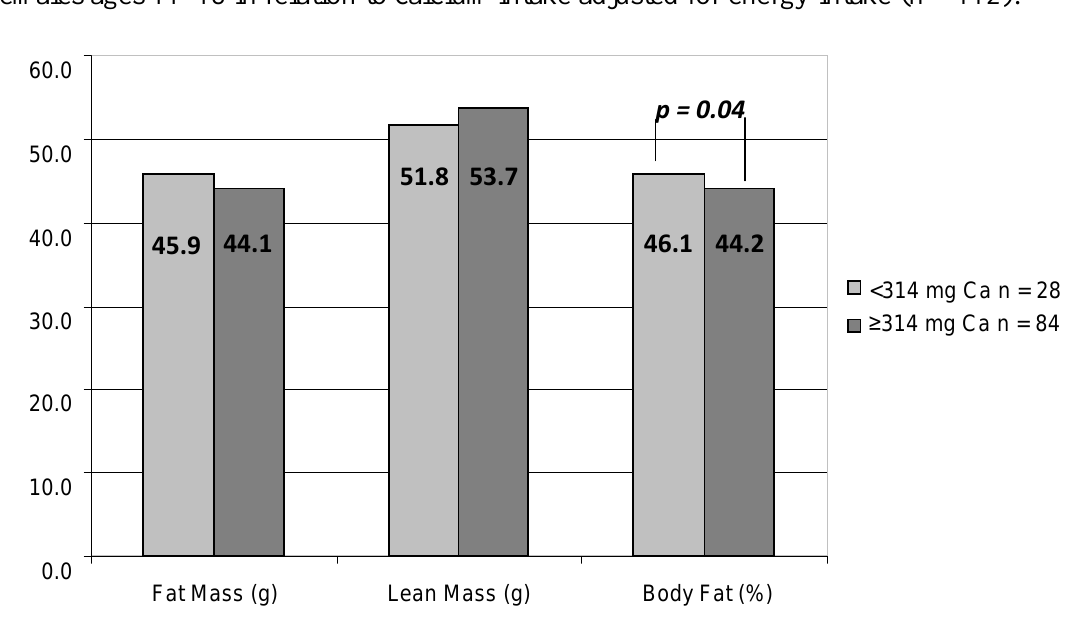
Figure 2. Body composition from dual energy X-ray absorptiometry for African-American females ages 11–18 in relation to calcium intake adjusted for energy intake (n = 112).